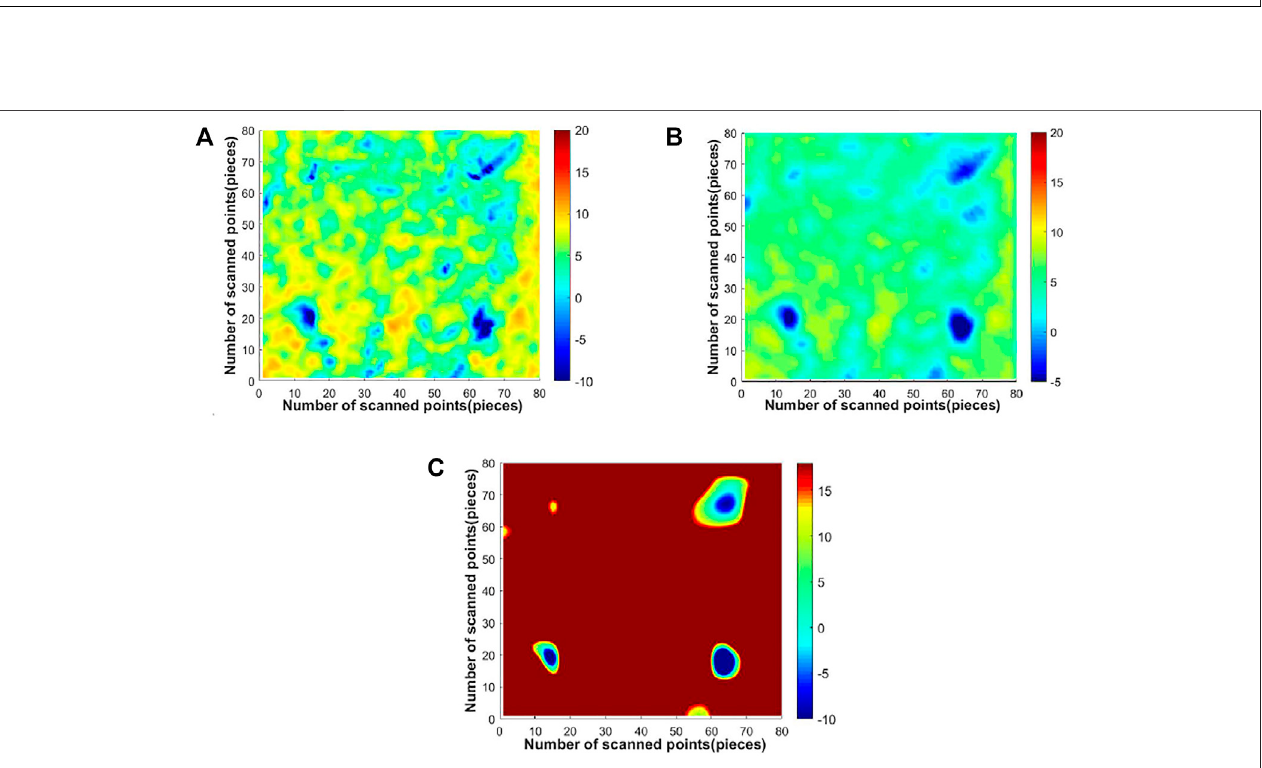
FIGURE 7 | Image of processing results of each method for adhesive debonding with a diameter of 6.0 mm in sample 1. (A) image of original detection, (B) Gaussian fi ltering, (C) method in this paper.